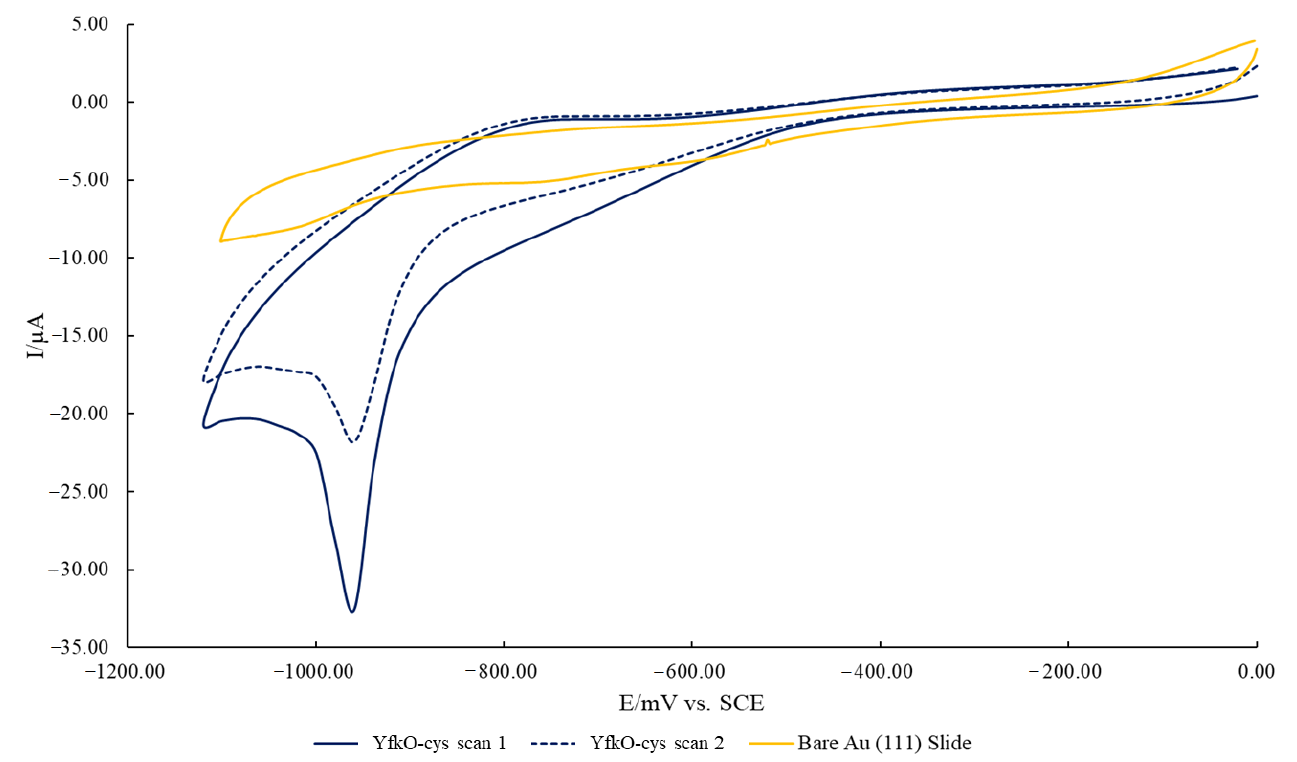
Figure 4. Cyclic voltammogram showing a reduction cycles of a 70 bare Au(111) coated glass slide and two consecutive reduction cycles of an Au(111) coated glass slide after 48 h incubation with YfkO-cys: scan 1 (solid line) = −959.47 mV, −32.60 µA and scan 2 (dashed line) = −959.47 mV, −21.82 µA. The potential is vs. SCE in an electrolyte of 0.1 M NaOH.